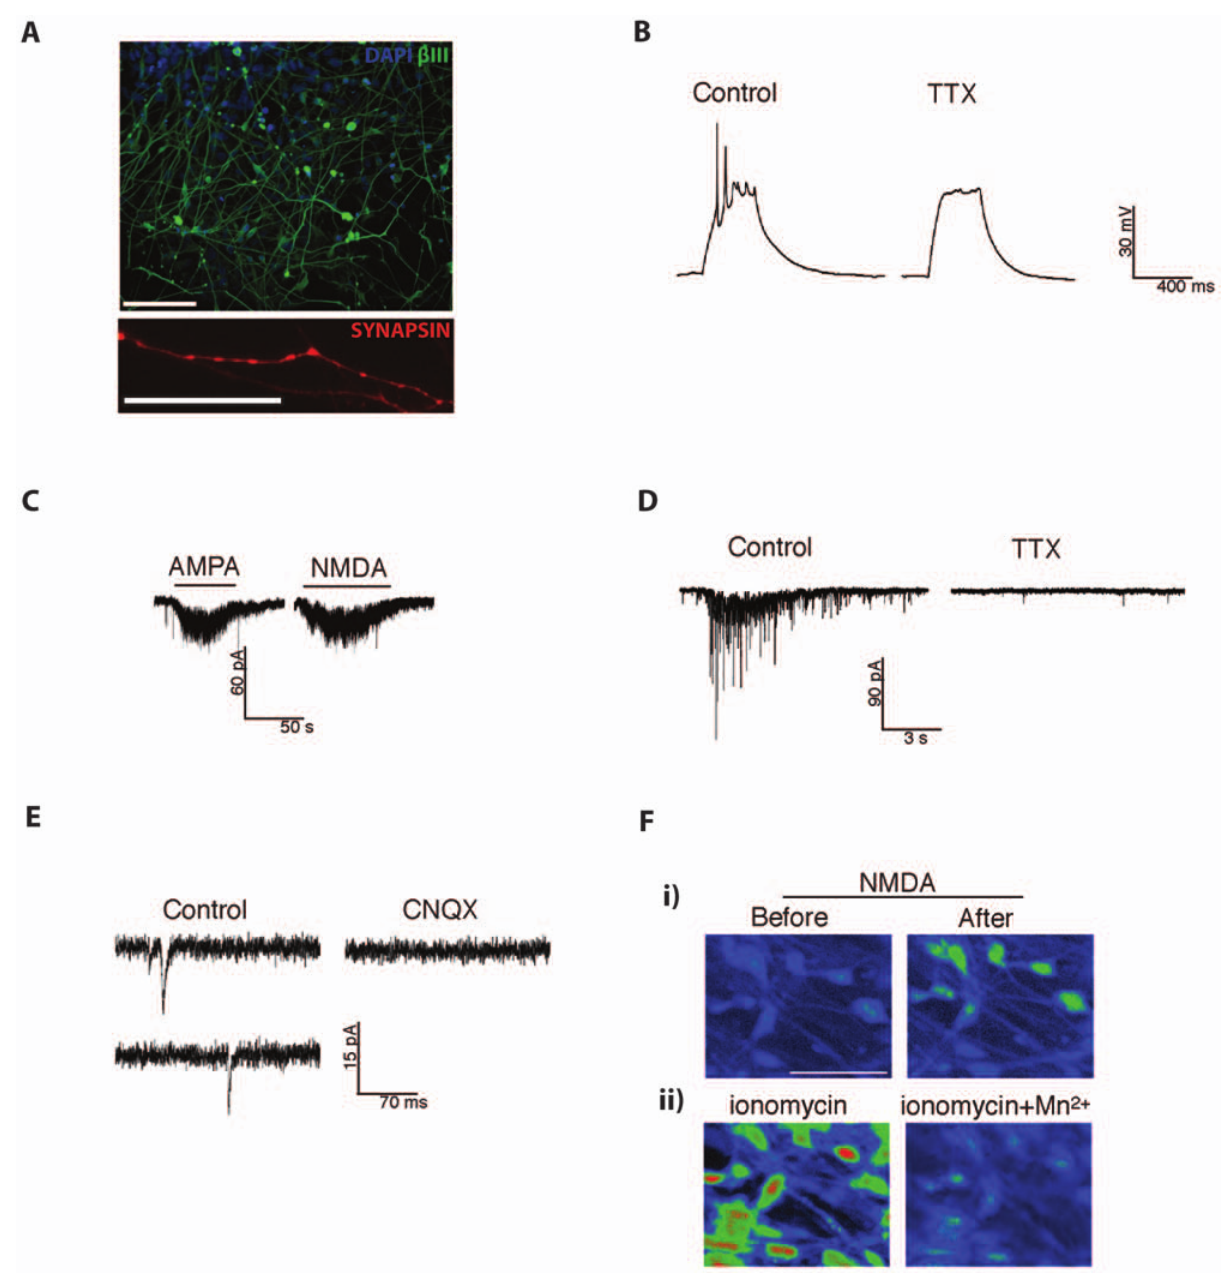
Figure 3. Plated aggregates give rise to b III positive neurons (A, upper image) that mature to synapsin positivity (A, lower image) within one week. SB431542 treated hESCs give rise to neurons that are electrophysiologically active. Current-clamp recording from an SB431542 generated neuron (28 days post-plating) showing that injection of positive current, from a resting membrane potential of –58 mV, gives rise to action potentials which are blocked by the voltage-dependent Na + channel blocker, TTX (300 nM) (B). Whole-cell voltage-clamp recording from an SB431542 generated neuron at 28 days post-plating, held at –60 mV, showing responses to bath application of the selective agonists AMPA (50 m M) and NMDA (100 m M) – both agonists evoke inward currents which are associated with increases in the noise level of the recording (C). In the presence of picrotoxin (50 m M) and in nominally Mg 2 + -free external recording solution TTX-sensitive ‘bursts’ of excitatory synaptic inputs are present in SB431542 generated neurons (28 days post-plating, D). Examples of CNQX-sensitive miniature EPSCs recorded from an SB431542 generated neuron at 28 days post-plating held at –70 mV and recorded in the presence of TTX (300 nM) and picrotoxin (50 m M) in an external recording solution containing 1 mM MgCl 2 to block NMDA receptor-mediated currents (E). NMDA receptor activation SB431542 generated neurons (28 days post- plating) causes intracellular Ca2 + influx. Example Fluo-3 fluorescence images (Fi) of SB431542 generated neurons before and after treatment with NMDA (100 m M for 1 minute). For comparison, a fluorescence image is also shown of the same field of cells 1 minute after treatment with ionomycin, which causes massive Ca 2 + influx and dye saturation, as well as an image after treatment with ionomycin + MnCl 2 , which quenches the dye, giving a fluorescence value approximately equivalent to 100 nM Ca 2 + (Fii) [26]. The images are pseudocoloured: cold colours indicate low fluorescence, and warm colours indicate high fluorescence.